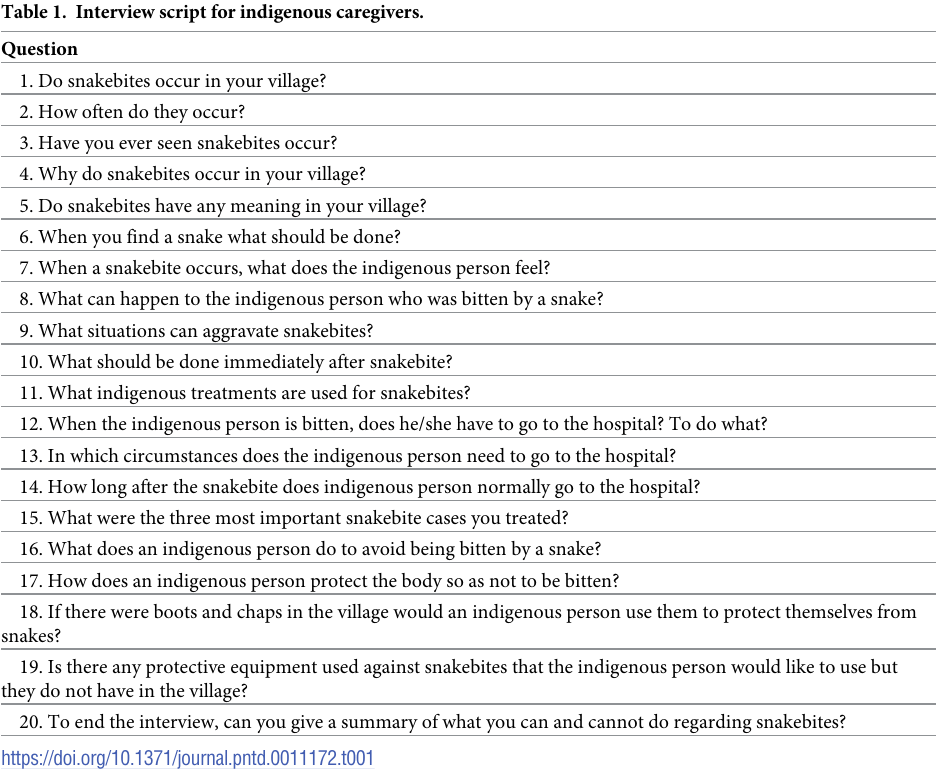
Table 1. Interview script for indigenous